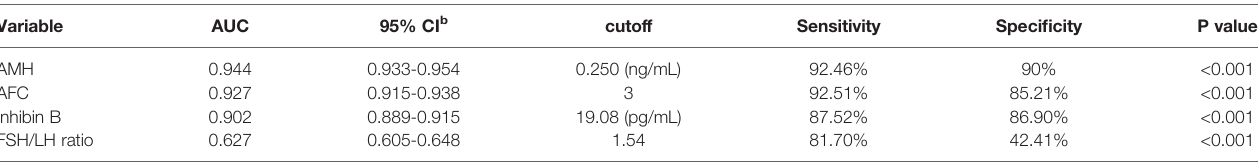
TABLE 3 | The ROC curve analysis for POI